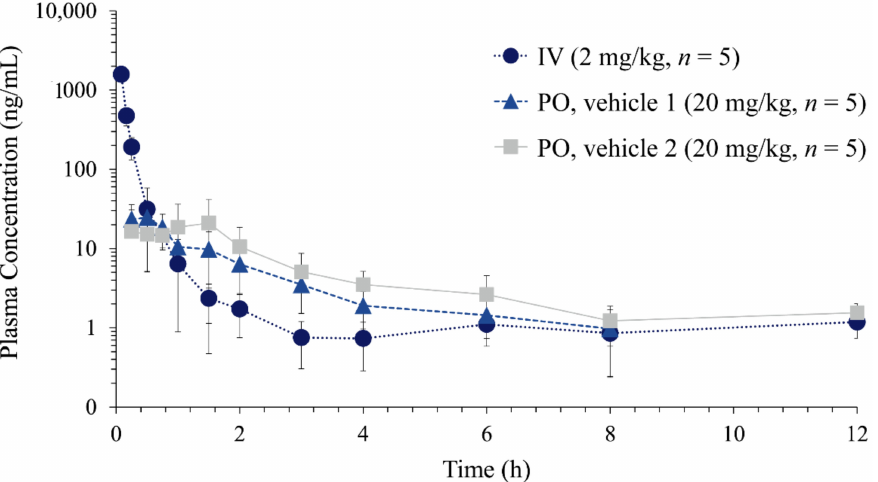
Figure 3. Plasma concentration vs. time profiles of nafamostat following intravenous injection (IV) of nafamostat dissolved in 5% DMSO (2 mg/kg, n = 5) and oral administration (PO) dissolved in vehicle 1 (10% DMSO, 20 mg/kg, n = 5) and vehicle 2 (10% DMSO and 10% Tween 80, 20 mg/kg, n = 5) in rats. Table 6. Pharmacokinetic parameters of nafamostat after intravenous (IV) injection (2 mg/kg)